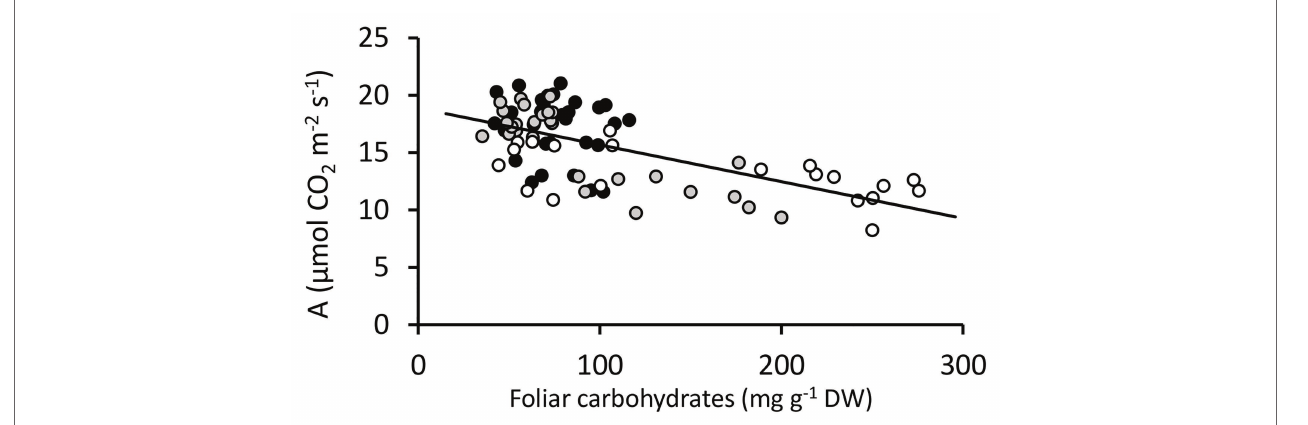
FIGURE 5 | Photosynthesis vs. foliar carbohydrates for DGAT + CO and NT Lolium perenne . Lines from each genetic background are shaded together irrespective of DGAT + CO or NT; NT1 and DGAT + CO1-2 ( ), NT2 and DGAT + CO3-4 ( ) and NT3 and DGAT + CO5